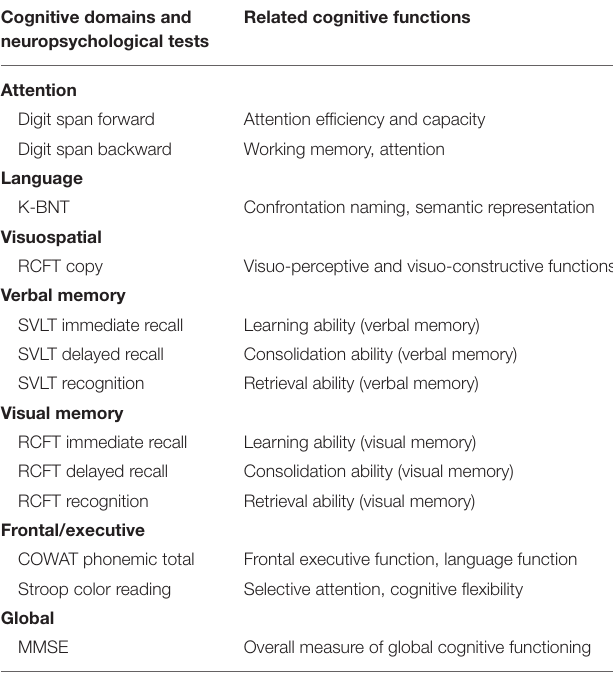
TABLE 1 | Brief descriptions of the neuropsychological tests and related cognitive functions. Cognitive domains and Related cognitive neuropsychological tests